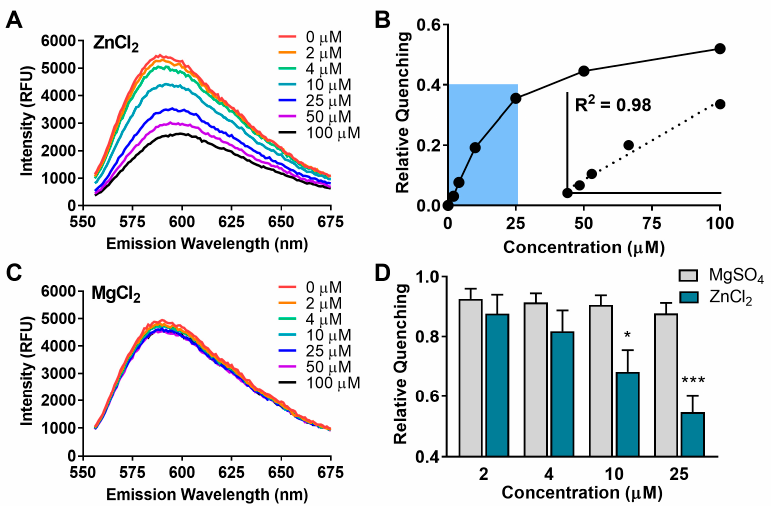
Figure 3. Nanoprobe response to metals in vitro. ( A ), Zn 2+ response curves (0 to 100 µM) and ( B ), representative calibration plot (inset from shaded region, 0 to 25 µM). ( C ), Mg 2+ response curves (0 to 100 µM) and ( D ), Quenching vs. concentration of added MgSO 4 and ZnCl 2 . Bars on graph indicate mean ± SEM. Statistics: * p < 0.05 vs. MgSO 4 , *** p < 0.001 vs. MgSO 4 , (two-way ANOVA with Sidak post hoc, n = 4).